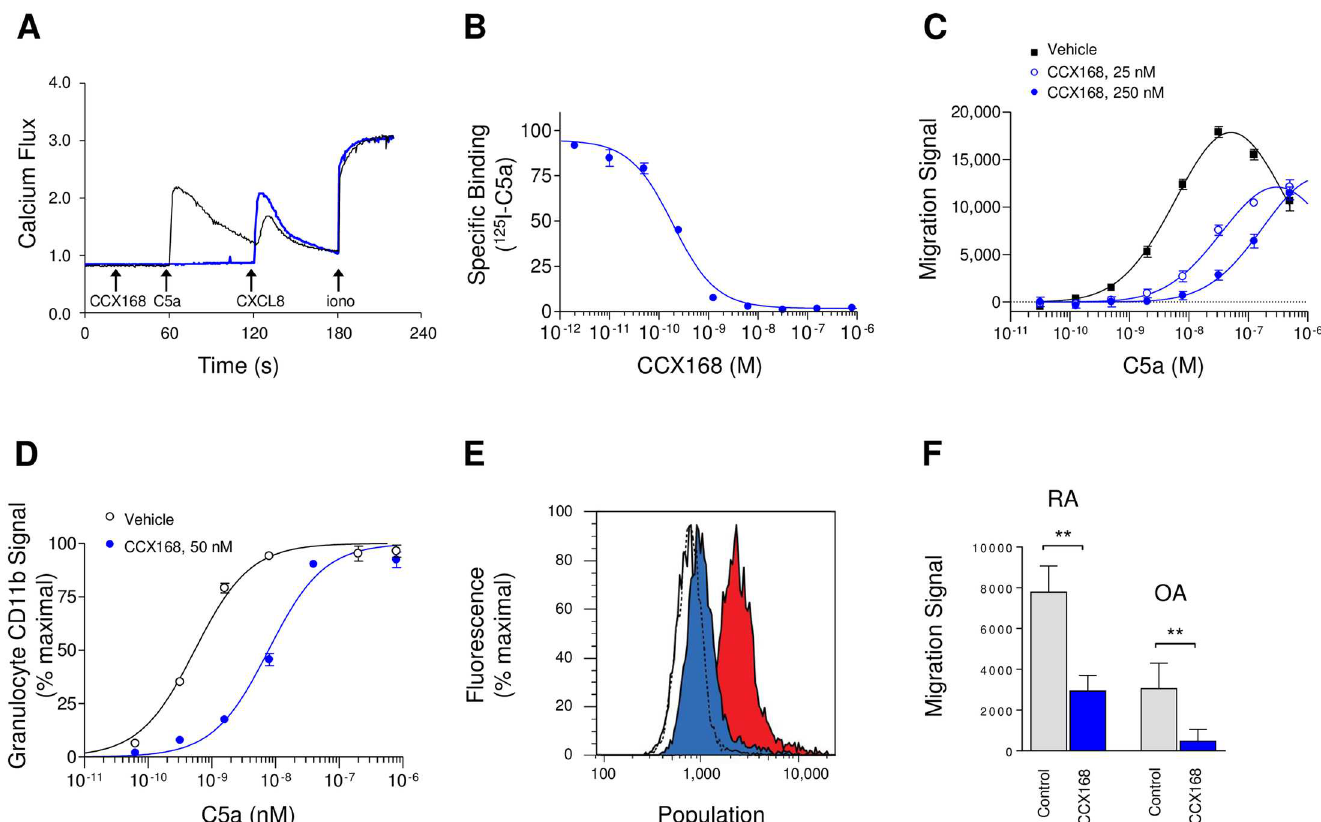
Fig 4. In vitro Characterization of CCX168 Using Freshly-Isolated Human Neutrophils or Human Whole Blood. (A) Sequential intracellular calcium release in human neutrophils in response to C5a (100 nM), CXCL8 (100 nM) or ionomycin (1 μ g/mL), in the presence (blue line) or absence (black line) of CCX168 (10 μ M). CCX168 blocked calcium release induced by C5a but not by the CXCR1 ligand CXCL8. (B) Bindingof [ 125 I]-C5a to human neutrophils in the presence of a range of concentrations of CCX168. CCX168 inhibited[ 125 I]-C5a bindingwith a potency (IC 50 value) of 0.2 nM. Each data point represents the mean of 4 replicates ± standard error, and the experiment was repeated2 separate times. (C) C5a-induced chemotaxis of leukocytes in human whole blood, in the presence of vehicle control ( ■ ), and 25 nM ( (cid:14) ) or 250 nM ( ● ) CCX168. CCX168 inhibited leukocyte chemotaxis in a dose-dependent manner. Each data point represents the mean of 8 replicates ± standard error, and the experiment was repeated 5 separate times. (D) C5a-induced upregulationof CD11b on the surface of neutrophils in human whole blood in the presence of vehicle control ( (cid:14) ) or 50 nM CCX168 ( ● ). CCX168 inhibitedCD11b upregulation. Each data point represents the mean of 4 replicates ± standard error, and the experimentwas repeated 4 separate times. (E) C5a-induced oxidative burst in isolated human neutrophilsin the presence of vehicle control (red histogram) or CCX168 (100 nM, blue histogram). The empty histograms represent untreated neutrophils(i.e., no C5a) in the presence of vehicle control (solid black line) or CCX168 (dotted black line). CCX168 blocked the C5a-induced oxidative burst but did not affect untreated neutrophils. The experiment was repeated 3 times. (F) Chemotaxis of leukocytesin human whole blood towards synovialfluid in the presence of vehicle control or CCX168 (100 nM). Experiments using synovial fluid from a patient with rheumatoidarthritis (RA) or osteoarthritis (OA) are shown. CCX168 inhibitedleukocyte chemotaxis induced by each of these samples. Each bar represents the mean of 8 replicates ± standard error, and the experimentwas repeated two times. ** p < 0.01 based on Student’s